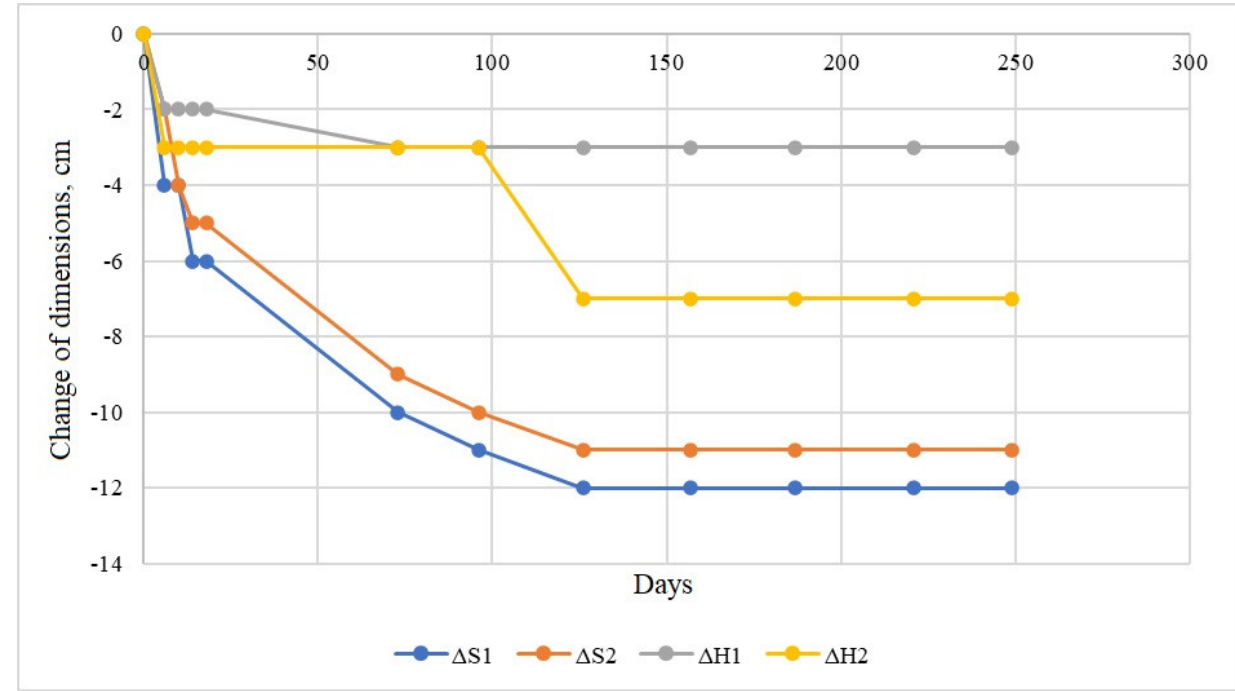
Figure A5. Change of the roadway dimensions—convergence control station no. 1.